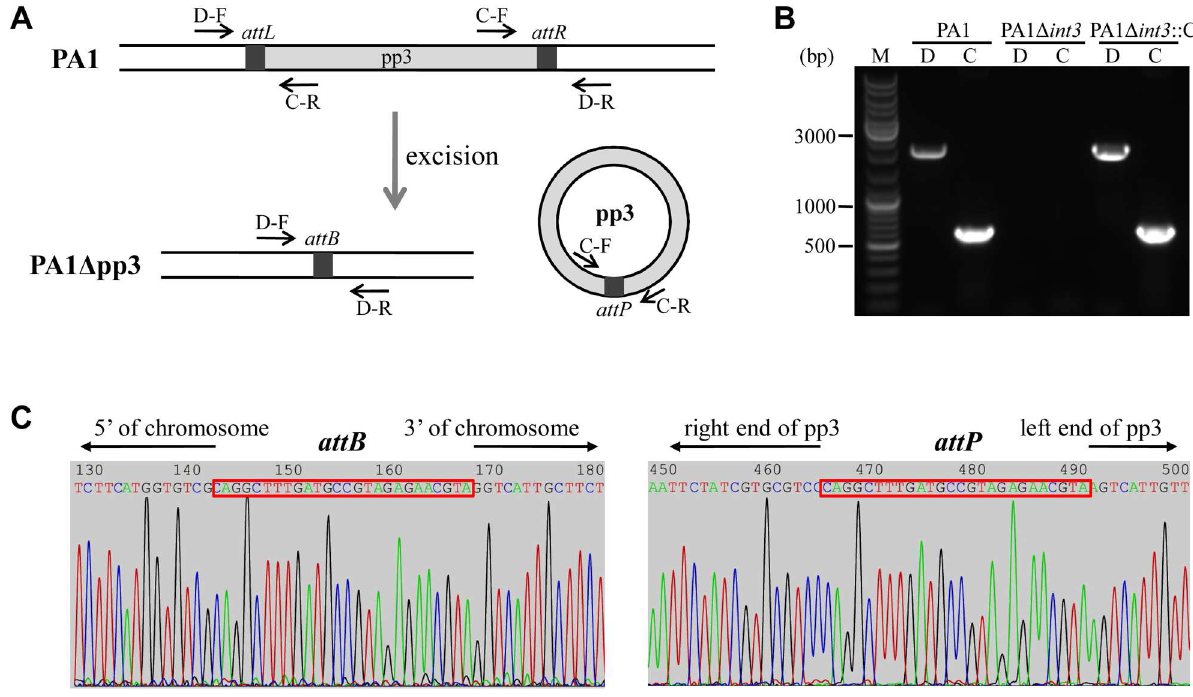
Fig 2. Excision and circularization of pp3 from the PA1 genome. (A) Schematic of pp3 excisionand circularization.Primer pairs D-F/ D-R and C-F/C-R are indicated. (B) Detection of pp3-excised PA1 chromosome (lanes labeledD) and circularform (lanes labeledC) of pp3. From left to right, genomicDNAs from strains PA1, PA1 Δ int3 and PA1 Δ int3 ::C were used as PCR templates. Lane M containsDNA size markers. (C) Sequencing of PCR products amplifyingacross the attB and attP sites uponpp3 excisionand circularization. The 26-bp attachment site of pp3 is indicatedby a red